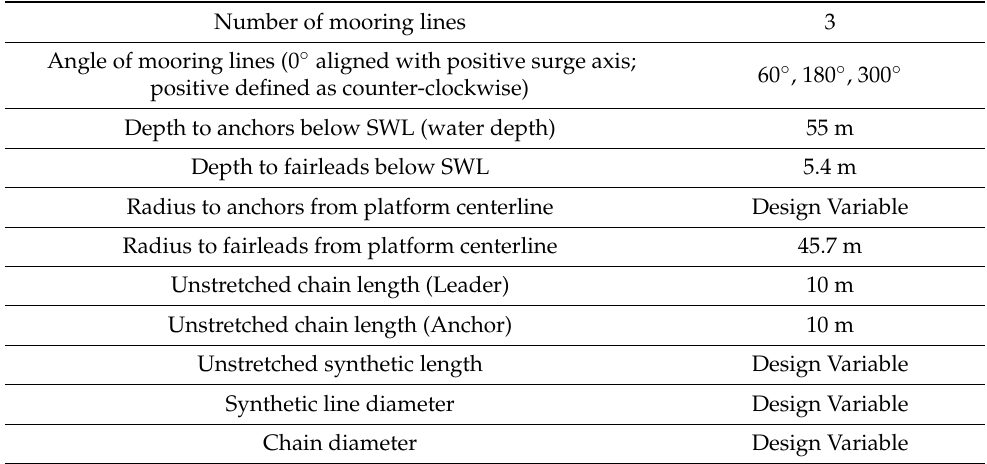
Table 1. Mooring System Properties.